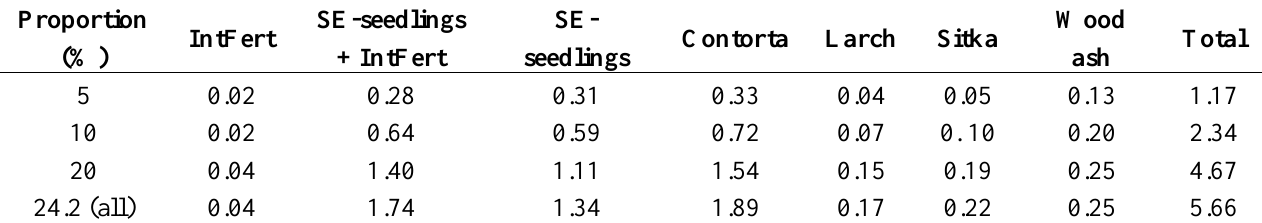
Table 5. Distribution of the forest area among the forest management treatments when increasing proportions of available forest land were used for IFM. Criteria according to the ―Base scenario‖ were used to select plots. Areas in million hectares.